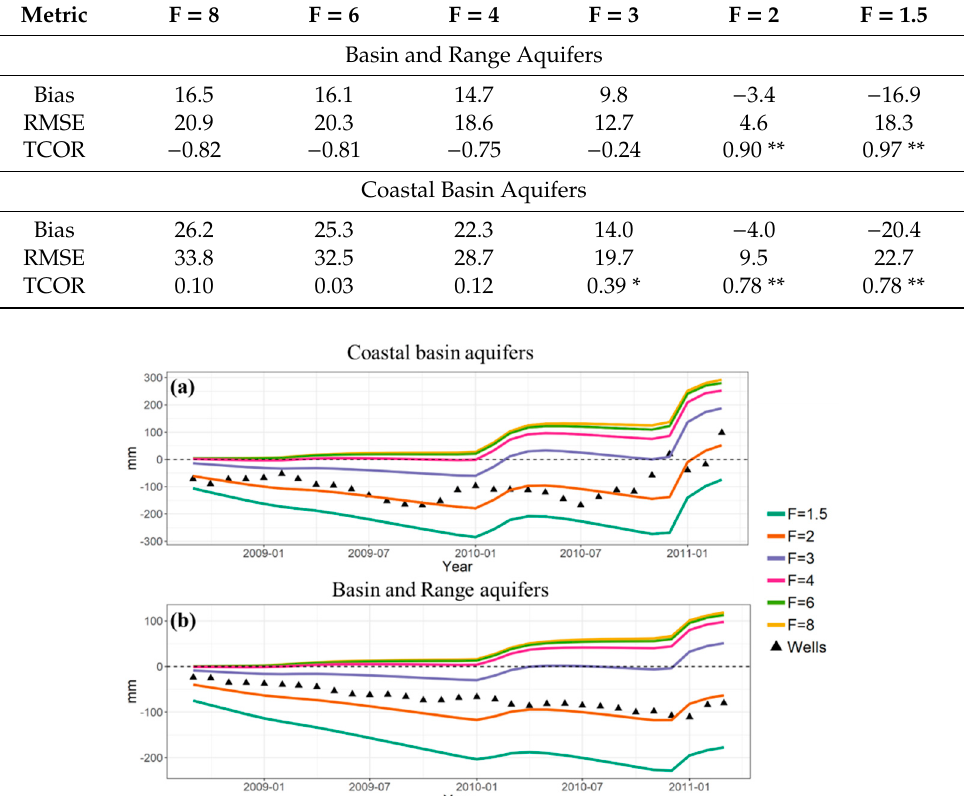
Table 1. Impact of baseflow decay factor (m − 1 ) on the SSIB-SIMGM simulations for the two main aquifer systems in the study area. Statistics represent 4-year domain-average terrestrial water storage (TWS) anomaly bias (mm), root-mean squared error (RMSE) (mm), and temporal correlation (TCOR). * and ** indicates correlation significance at 90% and 99% confidence levels, respectively.